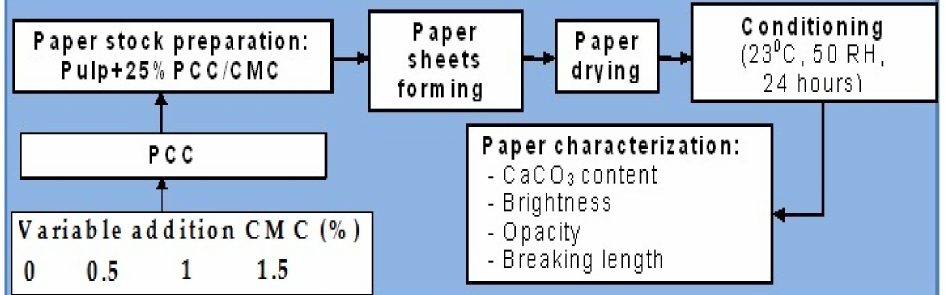
Figure 1. A schematic representation of the technological routes for the preparation of PCC–CMC and paper